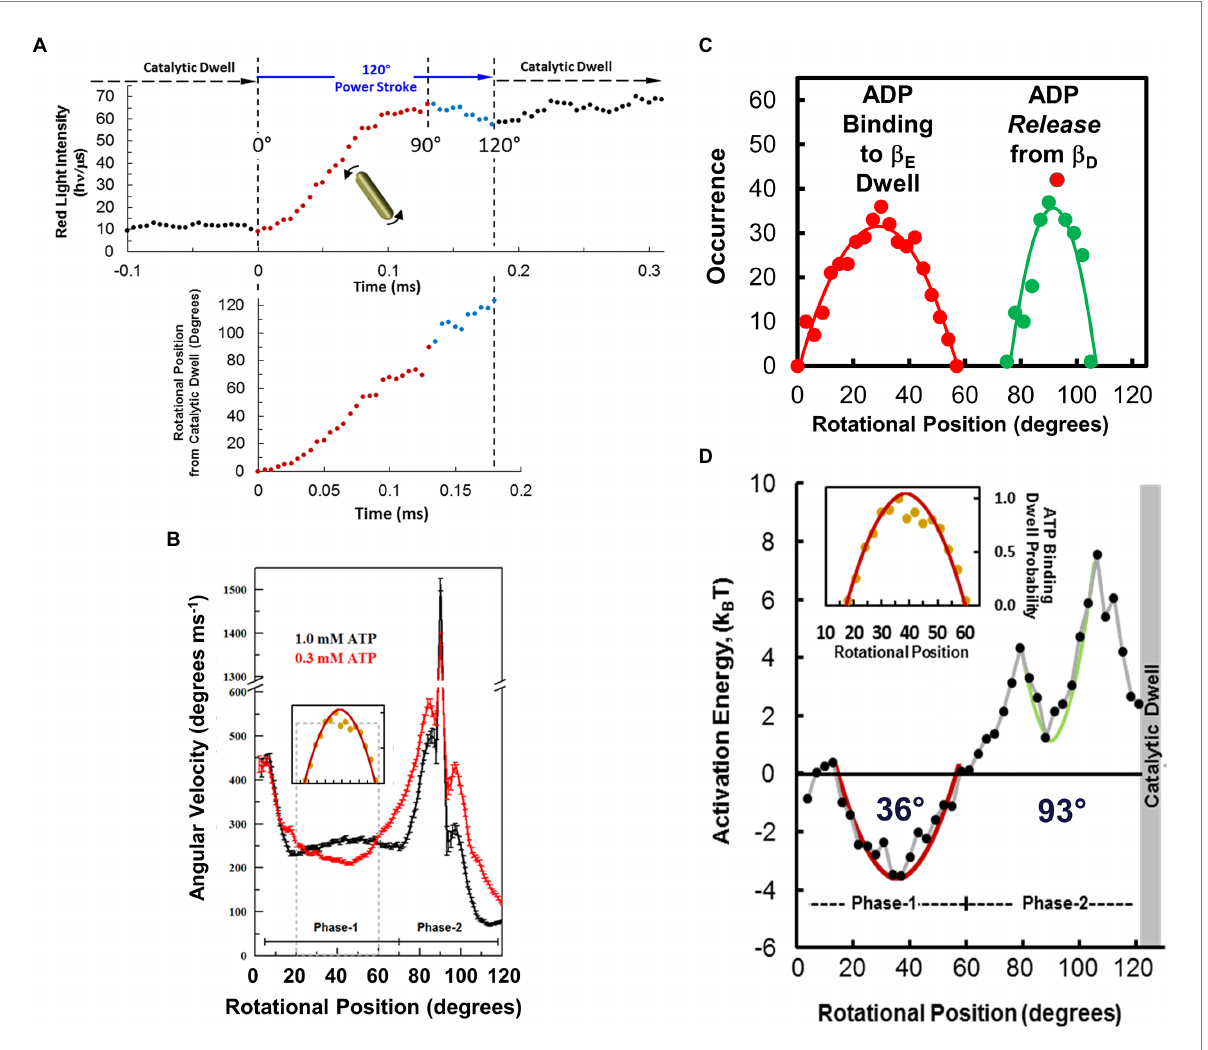
FIGURE 9 Measuring F 1 -ATPase power stroke angular velocity vs. rotary position from red light intensity of a rotating AuNR collected at 200 kHz (200,000 fps). (A) . Example of changes in scattered light intensity vs. time during an Ec F 1 power stroke in saturating 1 mM Mg-ATP. This power stroke occurred subsequent to the catalytic dwell, which had been set to a minimum light intensity by rotating the polarizer prior to data collection. Power stroke rotational position vs. time was calculated from scattered light intensity using Eq. 1 (red) and Eq. 2 (blue). (B) . Average power stroke angular velocity vs. rotational position of Ec F 1 ATPase-driven γ -subunit rotation binned for every 3 ° of rotation from the end of the catalytic dwell, which was designated as 0 ° in the presence of saturating 1 mM Mg-ATP (black) and 0.3 mM Mg-ATP (red). Inset: Distribution of ATP-binding dwells vs. rotational position in the presence of 0.3 mM Mg-ATP, which is proportional to the decrease in average angular velocity vs. rotational position at 0.3 mM Mg-ATP. (C) . Distributions of ADP-binding dwells (red) and ADP-dependent velocity decreases (green) vs. rotational position of the power stroke at 1.0 mM MgATP and 3 mM MgADP. (D) . Activation energy of the Ec F 1 -ATPase power stroke vs. rotational position at 1 mM Mg-ATP, 10 μ M Mg- ADP and 10 μ M Pi. Energy stored vs. extent of twist of a torsion spring with spring constants, κ = 50 k B T rad − 2 (red) and κ = 150 k B T rad − 2 (green) from equilibrium positions of 34 ° and 93 ° , respectively. Inset: Distribution of ATP-binding dwells vs. rotational position from B. This figure was reconfigured using data from Martin et al. (2014, 2018), Sielaff et al.